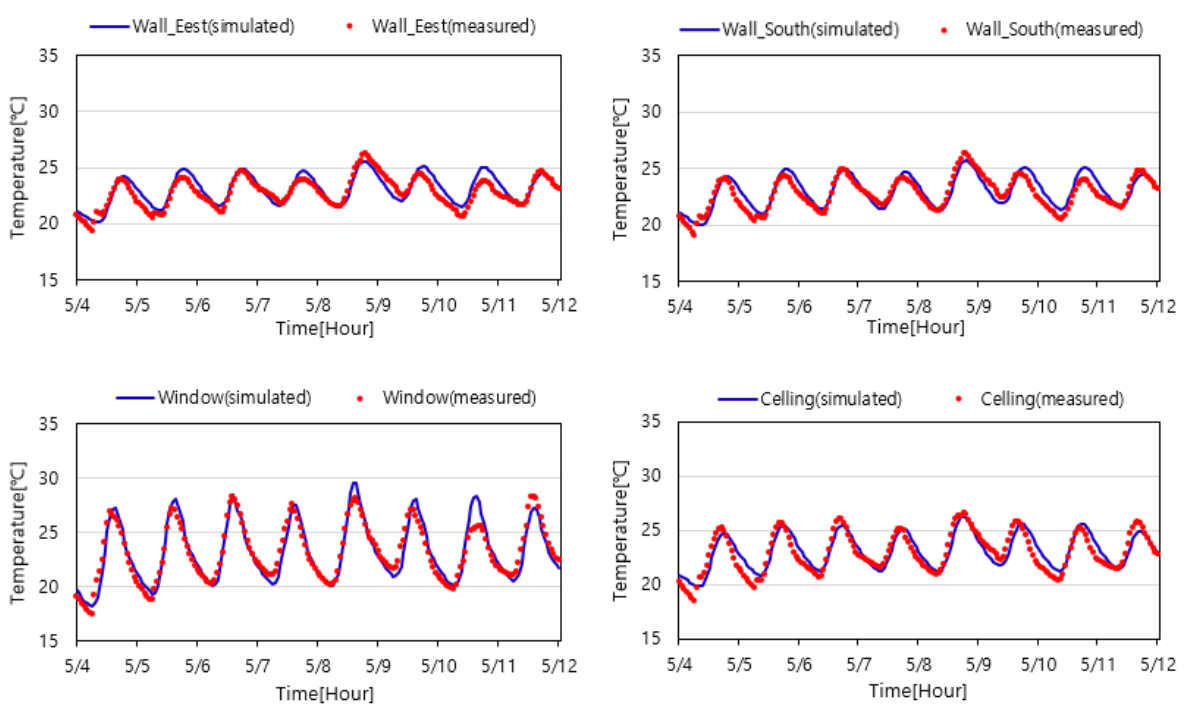
Figure 4. Comparison of measured and simulated surface